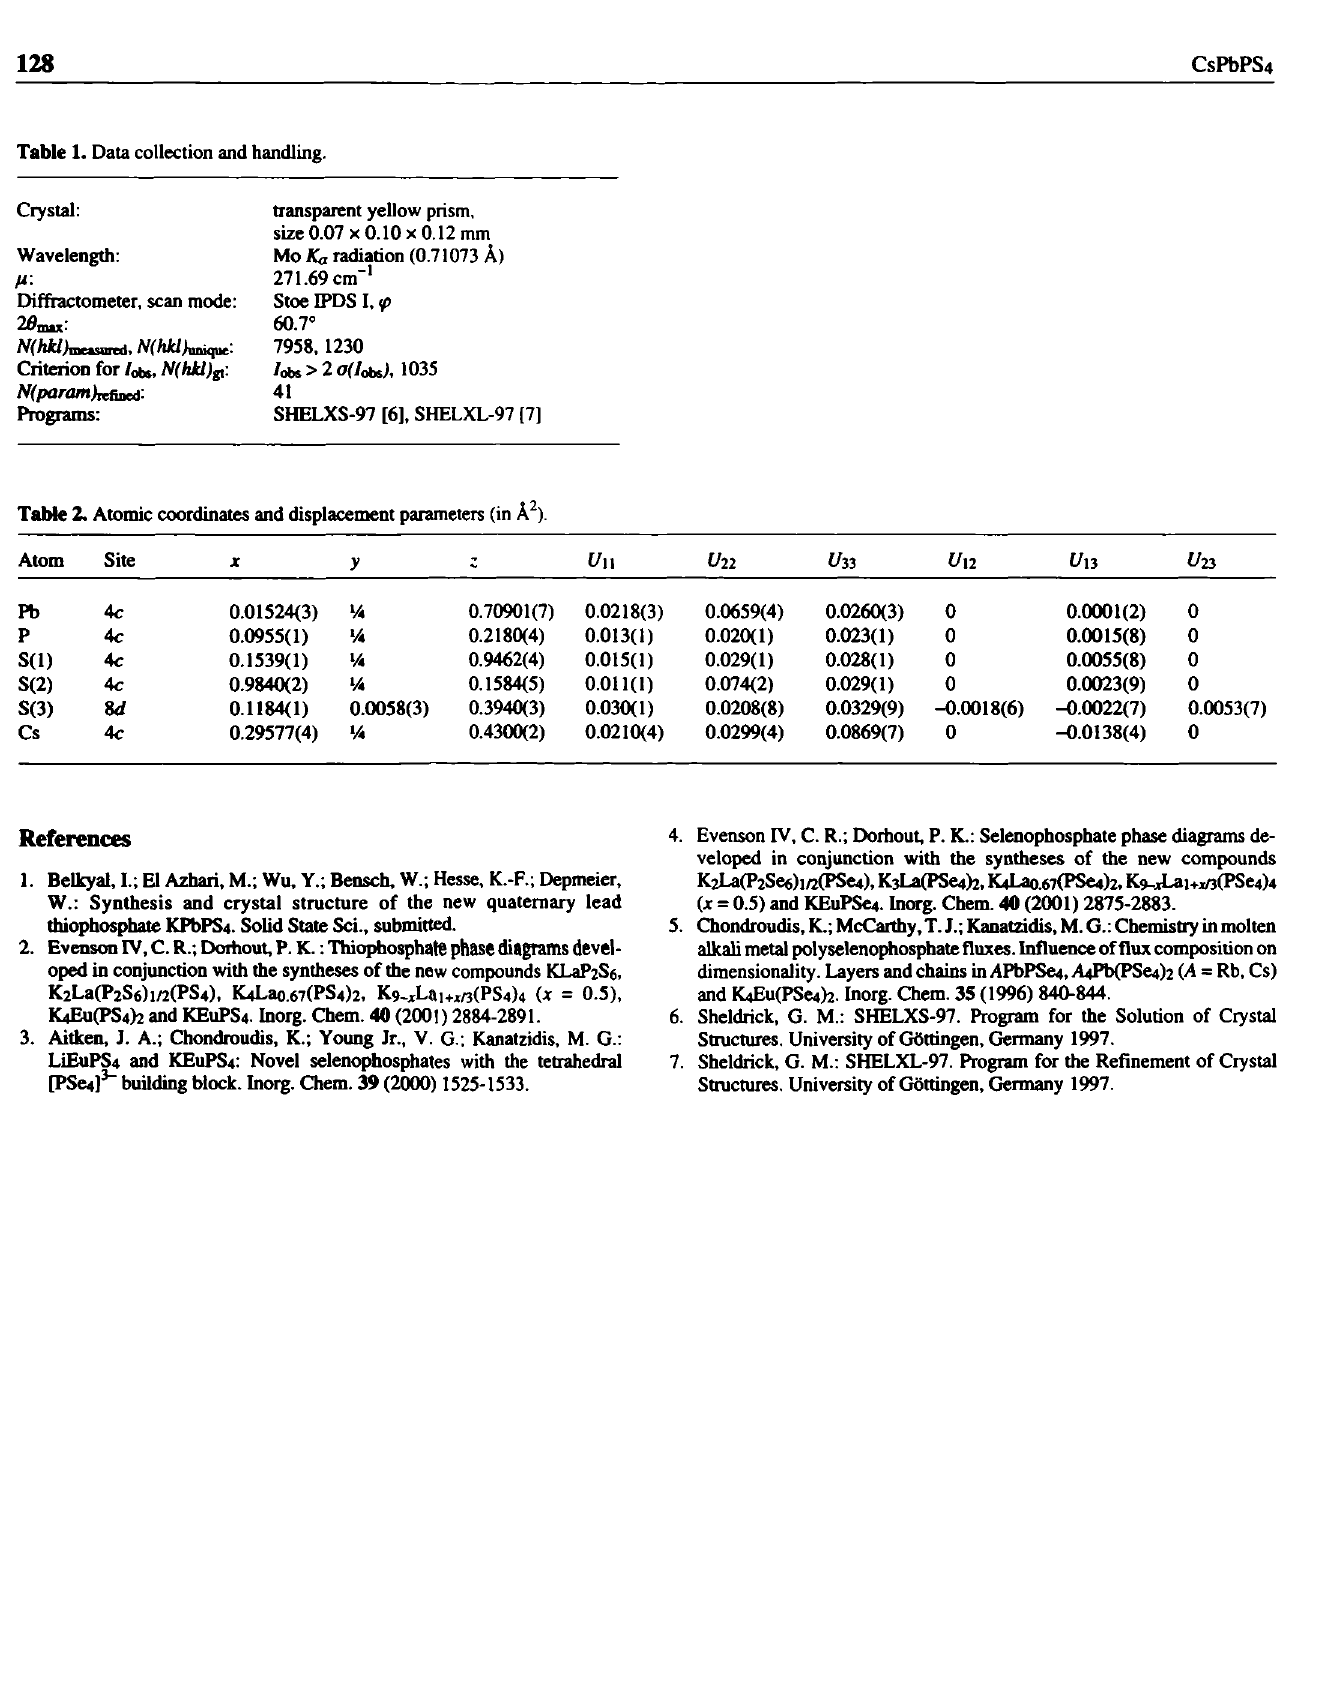
Table 1. Data collection and handling.